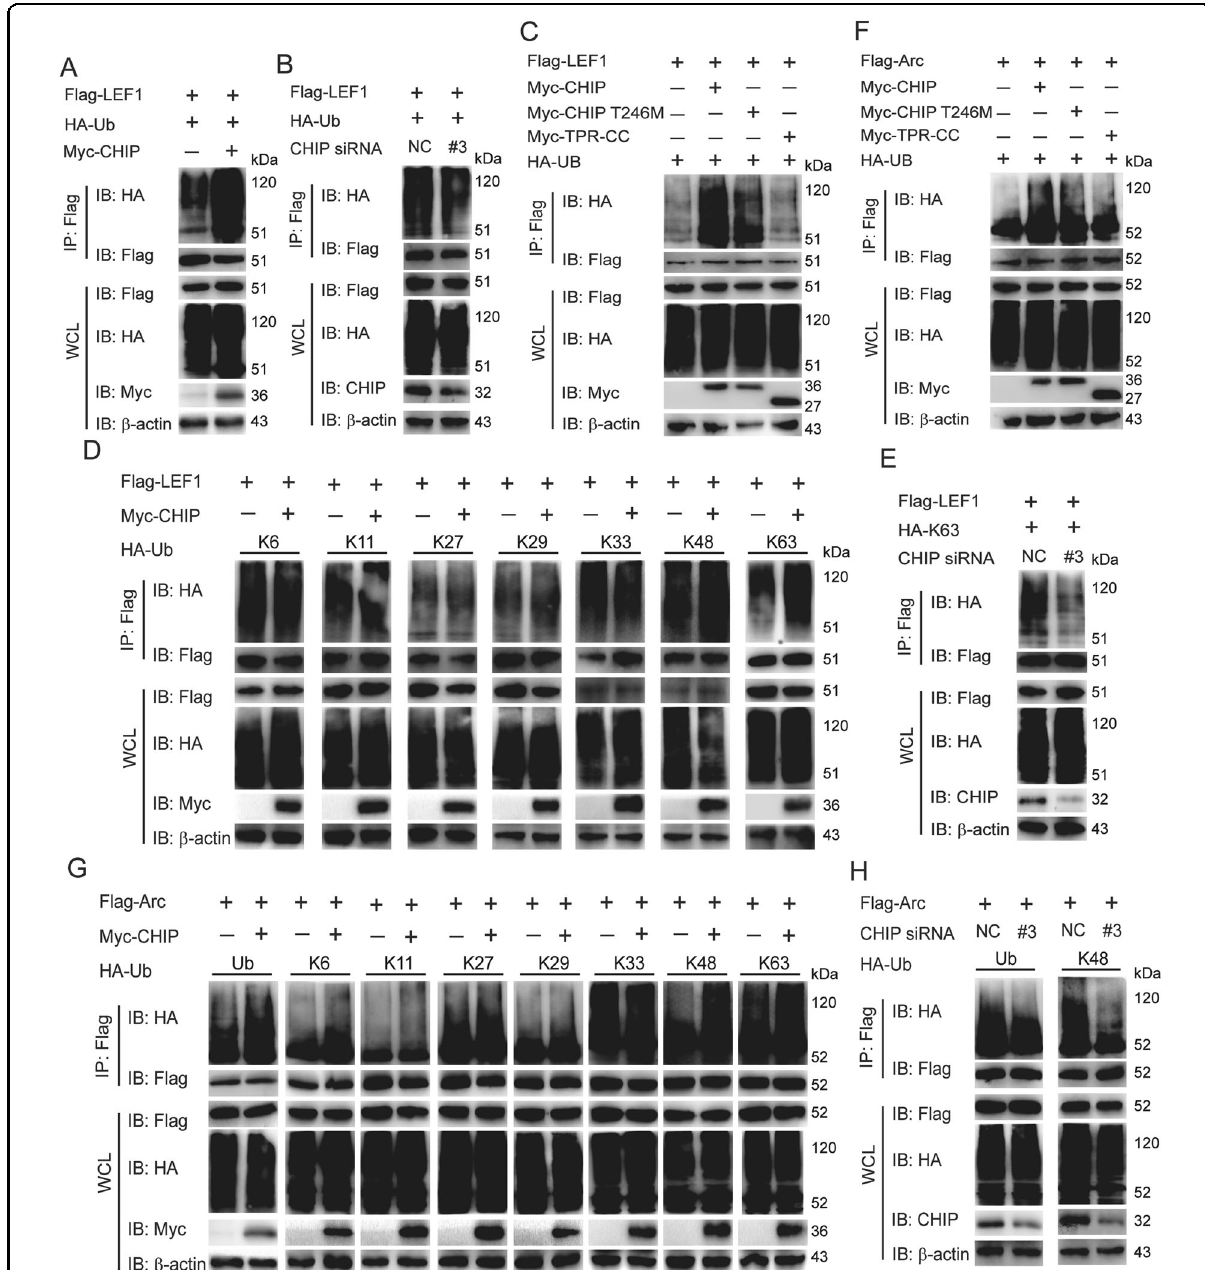
Fig. 4 CHIP increases the K63-linked ubiquitination of LEF1 and the K48-linked ubiquitination of Arc. A CHIP promoted the ubiquitination of LEF1. Immunoprecipitation and immunoblot analysis were performed to detect the ubiquitination of LEF1 after co-transfection of HA-tagged ubiquitin, Flag-LEF1, and Myc-CHIP in HEK293T cells. B Knockdown of CHIP reduced the ubiquitination of LEF1. HEK293T cells were transfected with HA-tagged ubiquitin, Flag-LEF1, and CHIP-speci fi c siRNA or control siRNA (NC) (40 nM), then the cell lysates were detected by co- immunoprecipitation and immunoblot. C – E HEK293T cells were transfected with indicated plasmids or CHIP-speci fi c siRNA as fi gures shown. Whole cell extracts were immunoprecipitated with anti-Flag beads and blotted with anti-HA antibody. The inactive mutants of CHIP couldn ’ t enhance the ubiquitination of LEF1 as CHIP WT ( C ). CHIP increased the K63-linked ubiquitination of LEF1 ( D ). Knockdown of CHIP reduced the K63-linked ubiquitination of LEF1 ( E ). F – H Immunoprecipitation and immunoblot analysis were performed to detect the ubiquitination of Arc after co- transfection with indicated plasmids or CHIP-speci fi c siRNA as fi gures shown. The inactive mutants of CHIP couldn ’ t enhance the ubiquitination of Arc ( F ). CHIP increased the K48-linked and K63-linked ubiquitination of Arc ( G ). Knockdown of CHIP reduced the ubiquitination, even the K48-linked ubiquitination of Arc ( H ). All results were representative of three independent experiments.